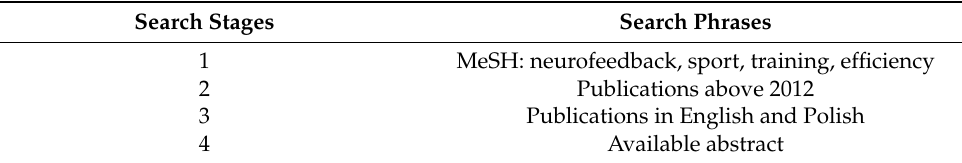
Table 1. Stages of literature search.